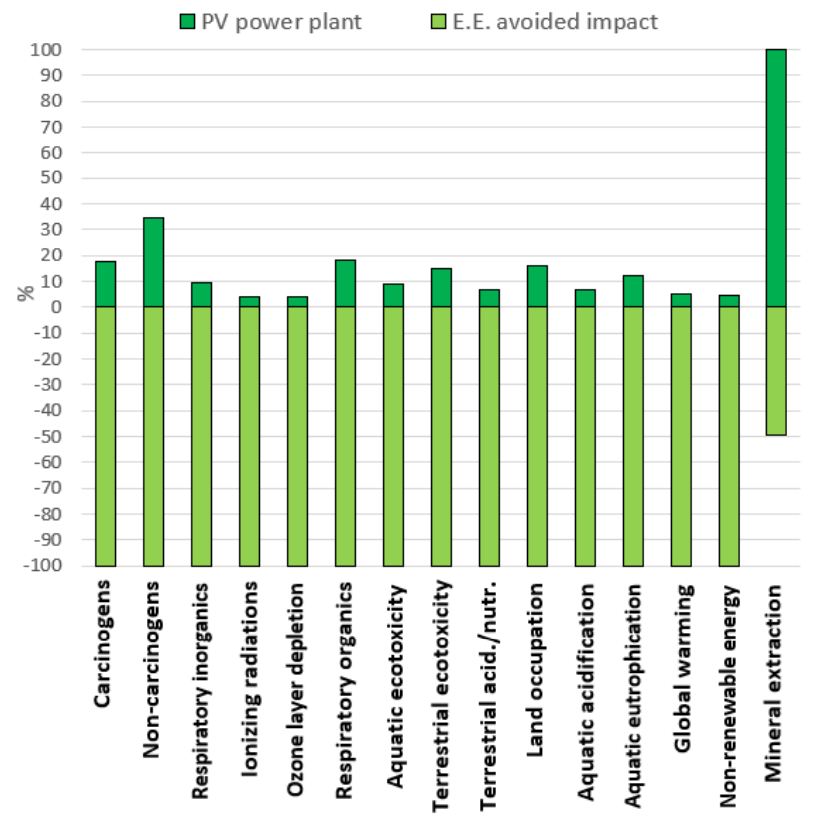
Figure 6. Midpoint indicators for configuration C1 without energy storage.